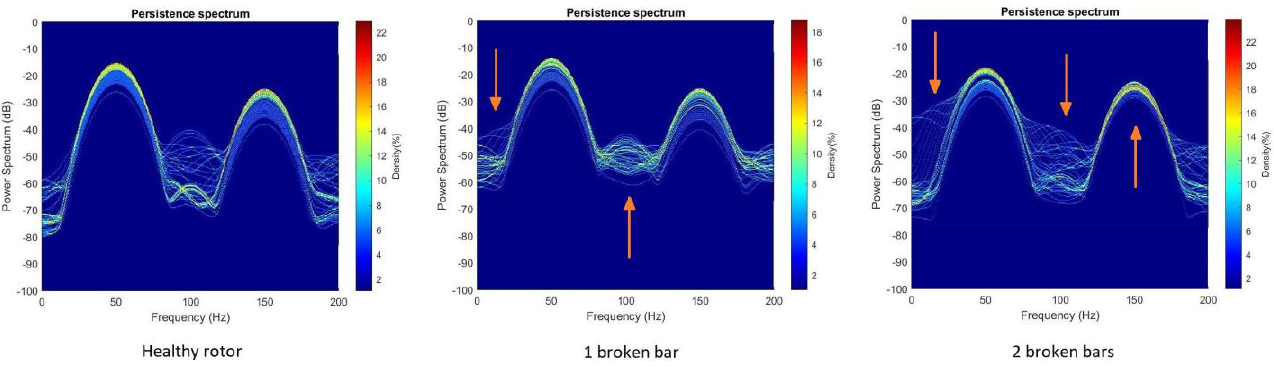
Figure 14. Example of differences in PS for each health state of the rotor.